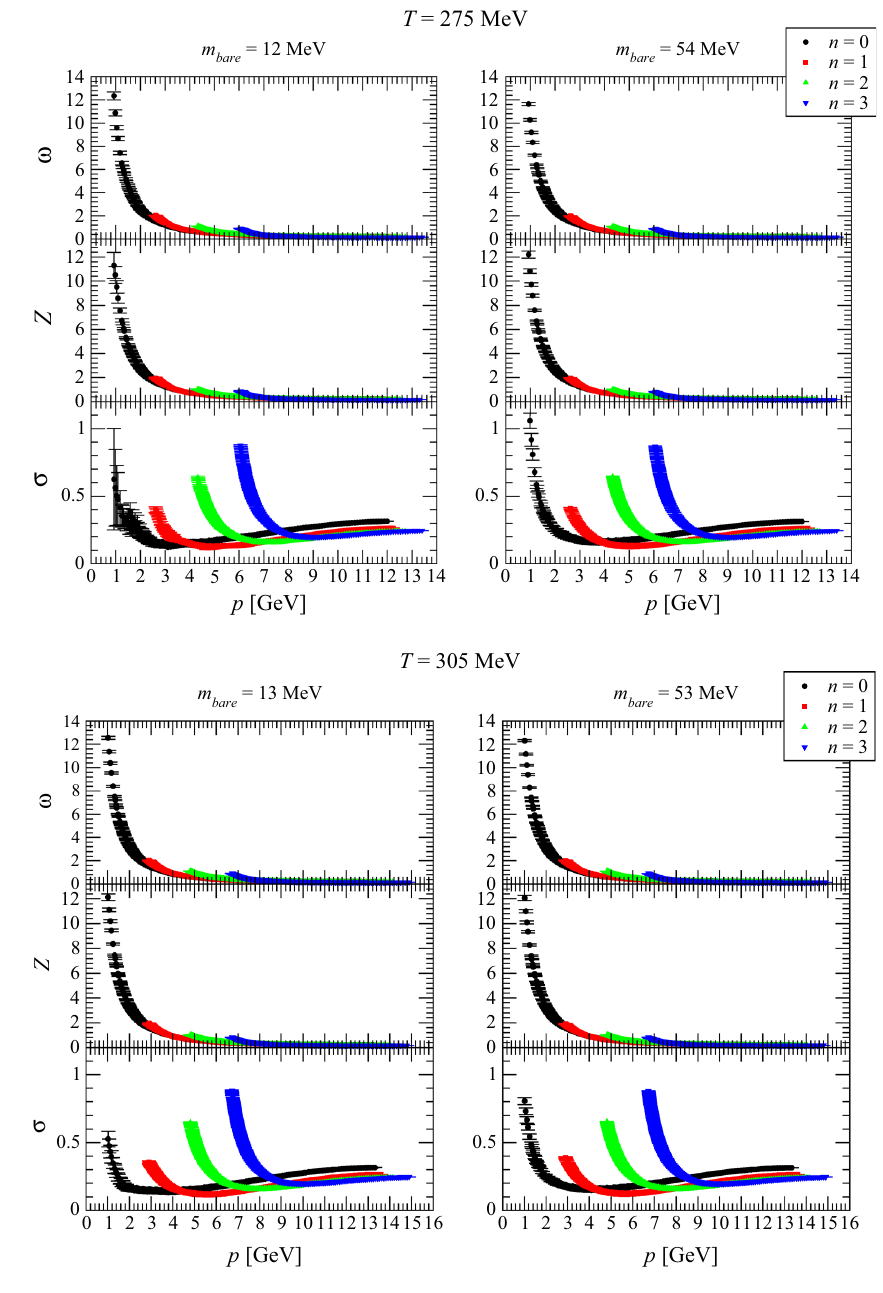
Fig. 3 The same as in Fig. 1 but for T = 275 MeV